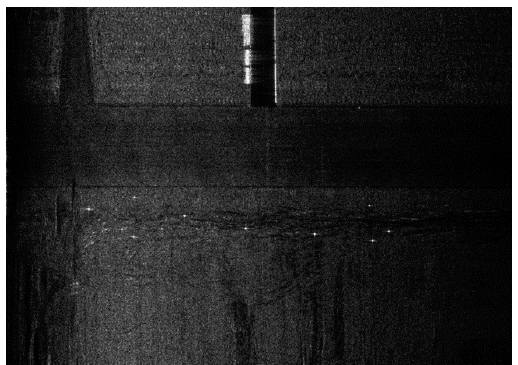
Figure 7. SLC image of Channel 1; this image, zoomed in on in Figure 8, contains GCPs and a flat ground. Remote Sens. 2018 , 10 , x FOR PEER REVIEW